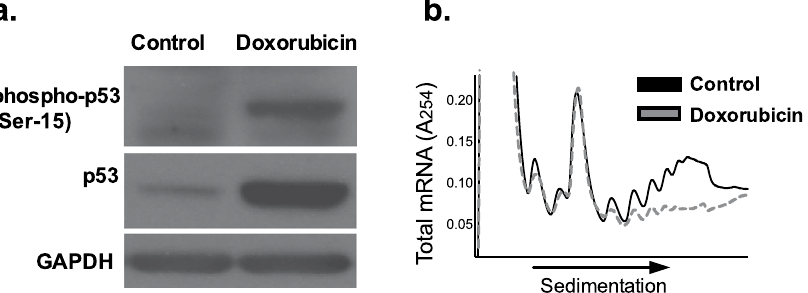
Figure 6. β cell DNA damage to induce p53 activation leads to global reductions in mRNA translation. MIN-6 cells were treated with doxorubicin to directly induce DNA damage. ( a ) Protein levels of both total and phospho-p53 were assayed after 12 hours of treatment with doxorubicin. ( b ) Global PRP analysis after 48 hours of doxorubicin